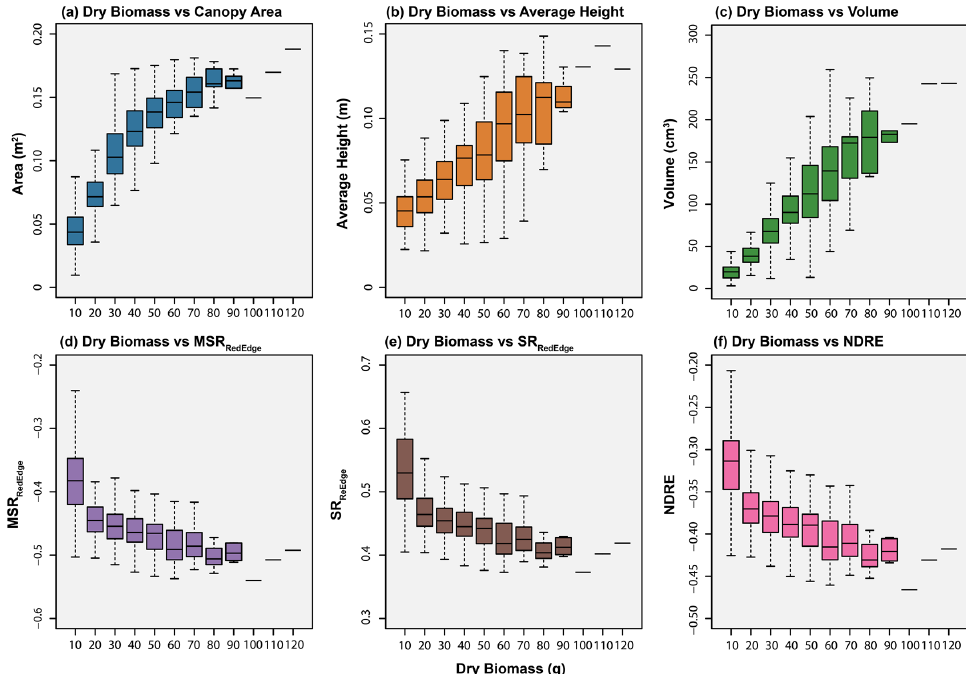
Figure 8. Box plots showing the variations in strawberry canopy geometric parameters and VIs with the increase in dry biomass. ( a ): dry biomass vs canopy area, ( b ): dry biomass vs average height, ( c ): dry biomass vs volume, ( d ): dry biomass vs MSR RedEdge , ( e ): dry biomass vs SR RedEdge , ( f ): dry biomass vs NDRE. The x axis represents different biomass intervals. For dry biomass, the interval is set as 10. For example, “10” and “20” represent the ranges of [0, 10] and [10, 20], respectively.